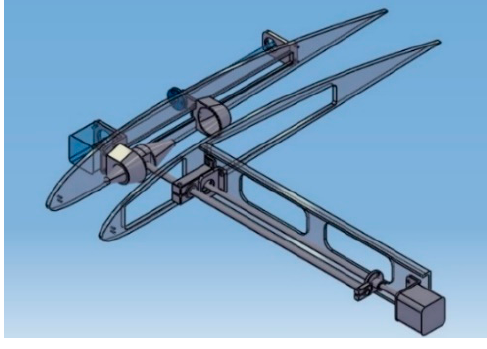
Figure 2. Wingtip-jointed mechanism.